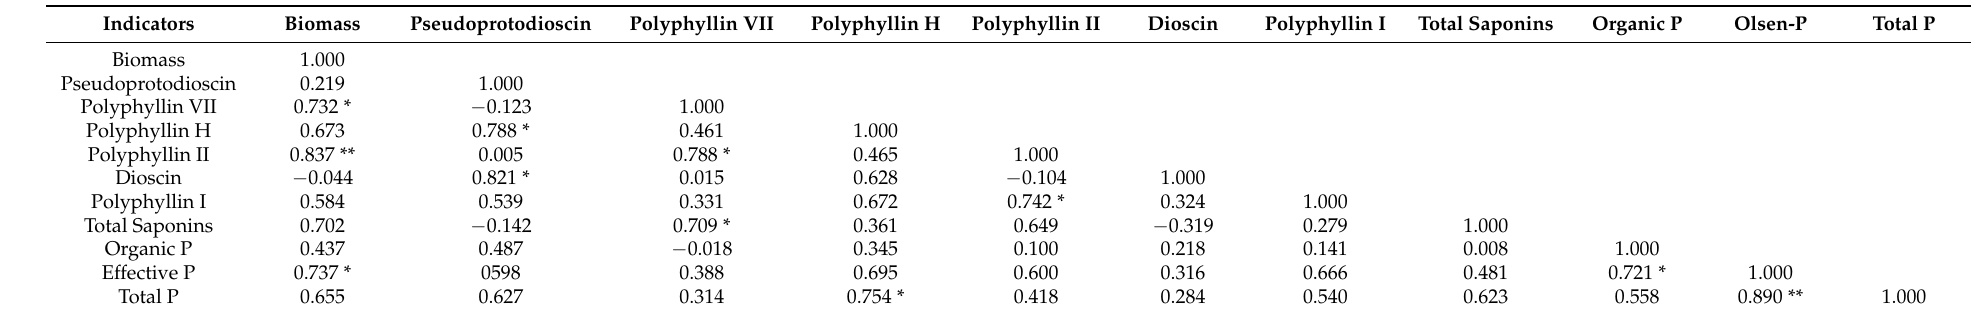
Table 3. Correlation analysis of the biomass, saponin, and P in Paris polyphylla var. yunnanensis .